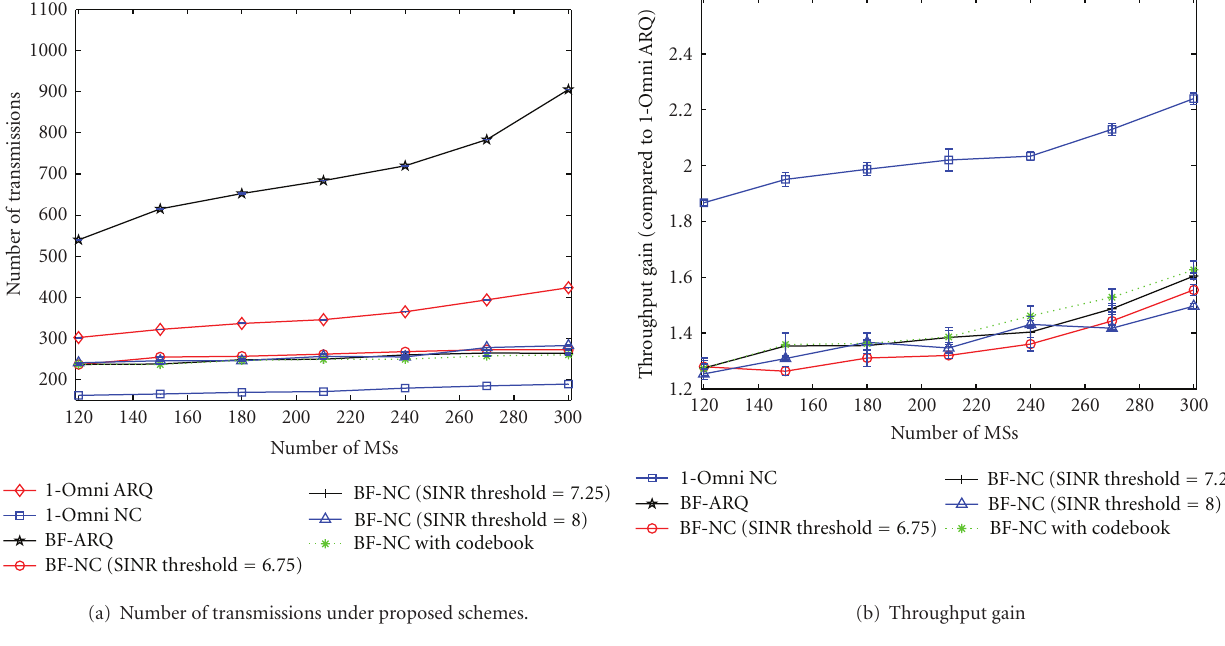
Figure 11: Simulation results for network topology scenario of Figure 7(a) when varying the number of